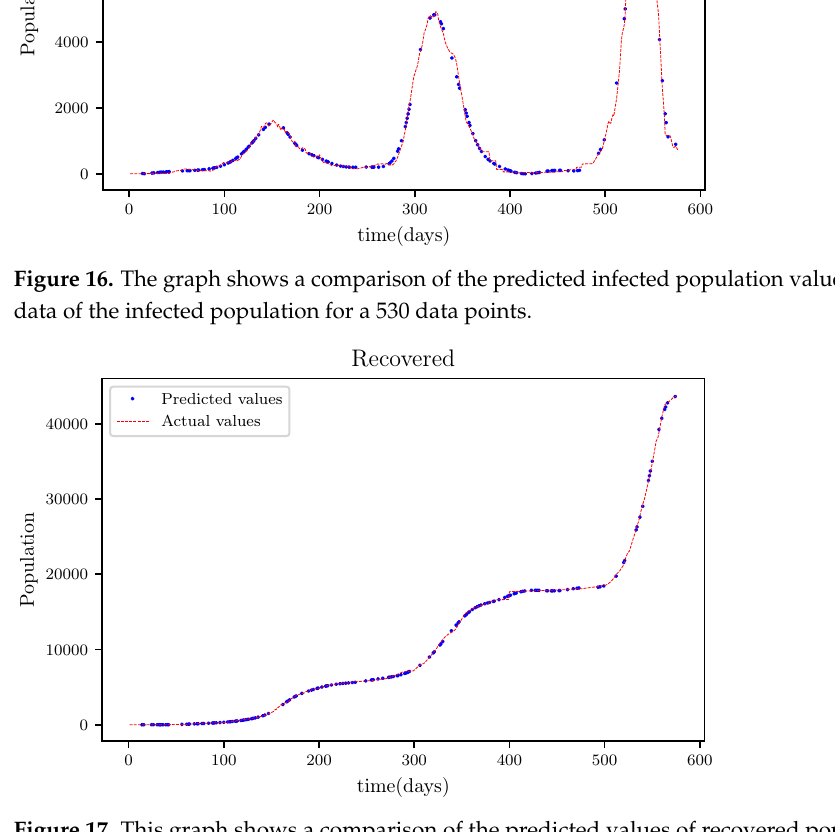
Figure 17. This graph shows a comparison of the predicted values of recovered population and the actual data of the recovered population for a 530 data